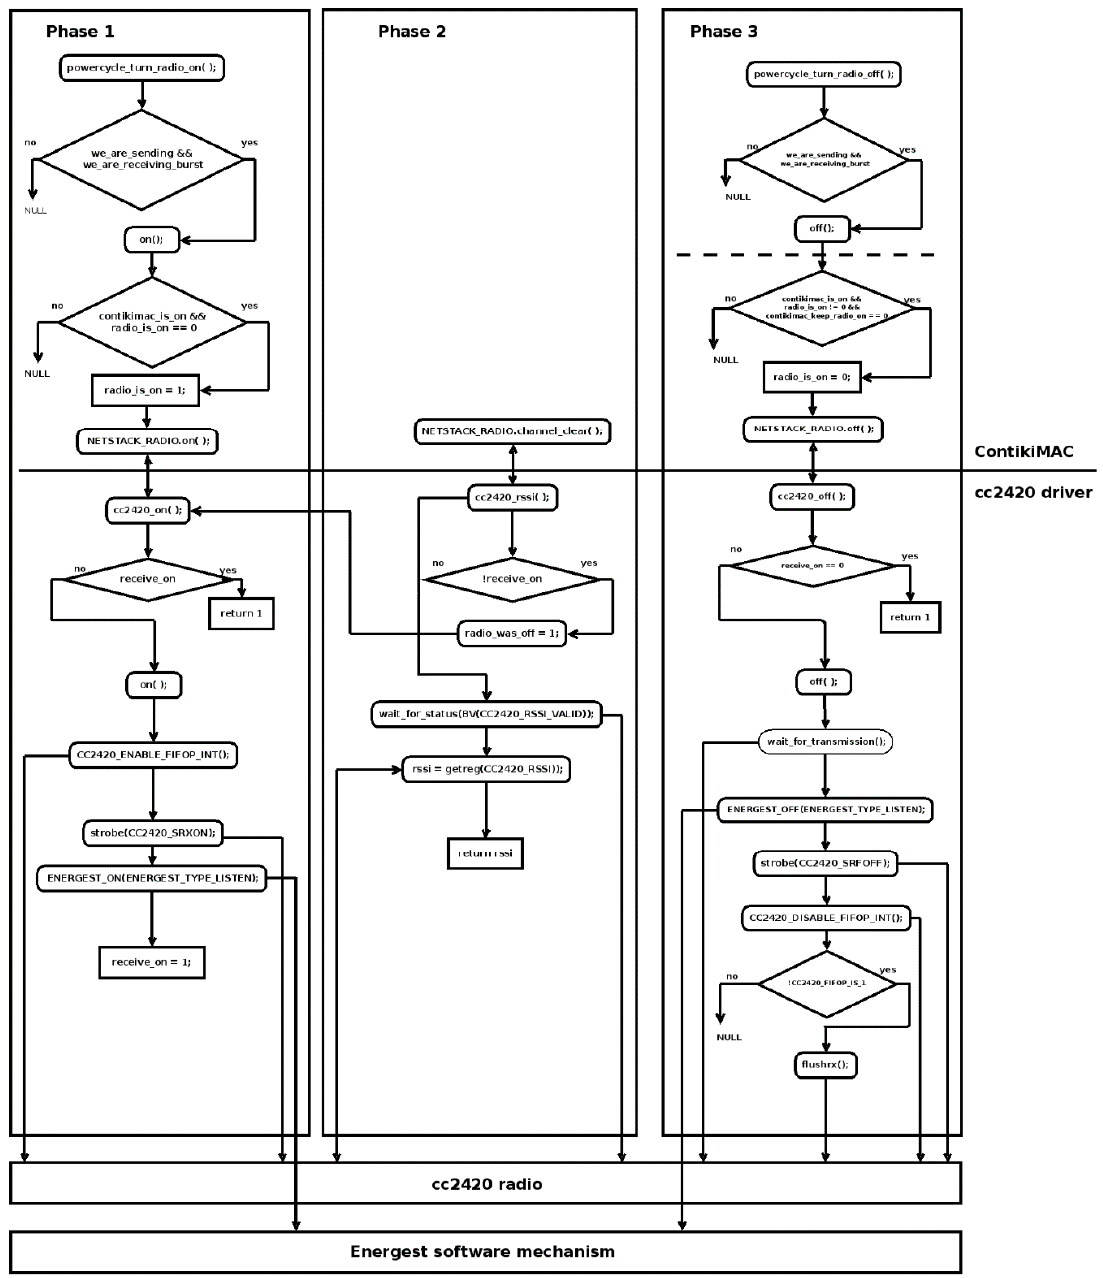
Figure 3. Diagram of the relationship between RDC, the radio driver, and the Energest module in performing a single RSSI.